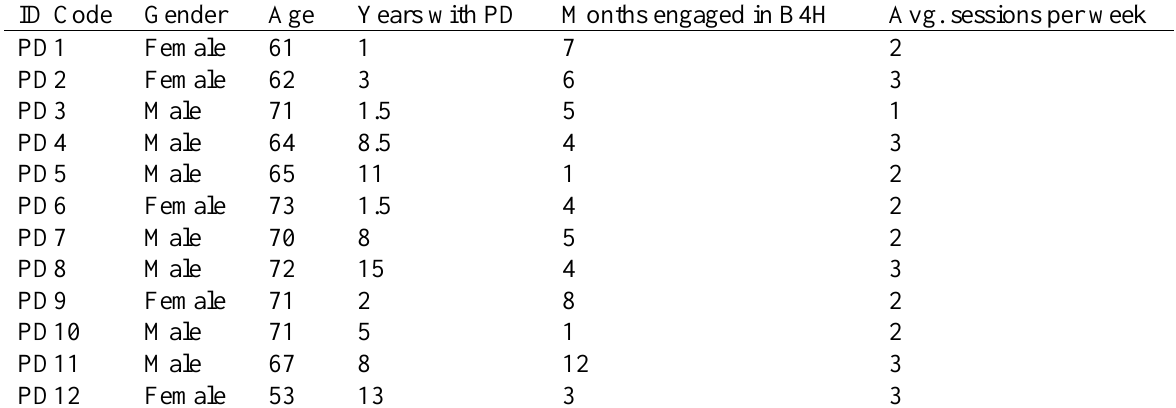
Table 1. Participant